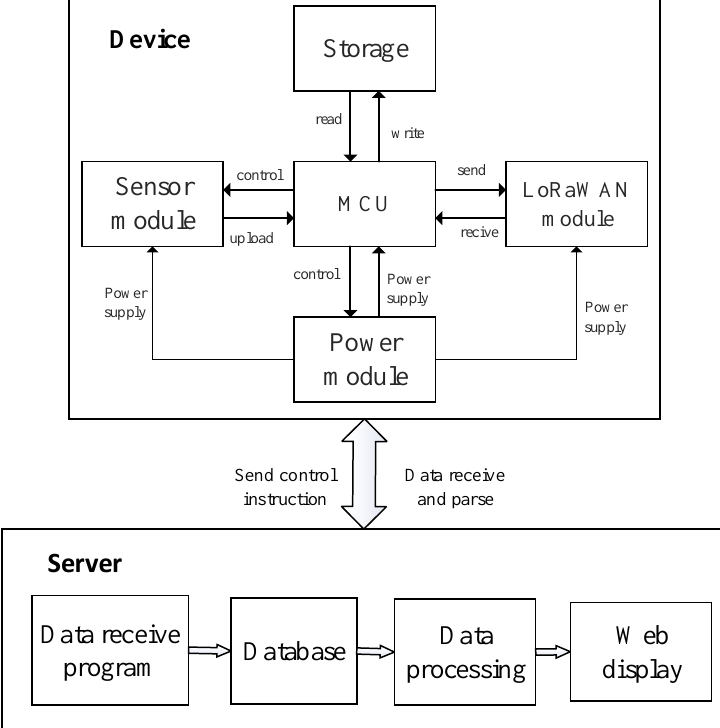
Figure 2. LoRa monitoring system consists of monitoring devices ( top ) and a data server ( bottom ). Arrows between different modules shown data flow and module control procedures. MCU = microcontroller unit; WAN = wireless area network.